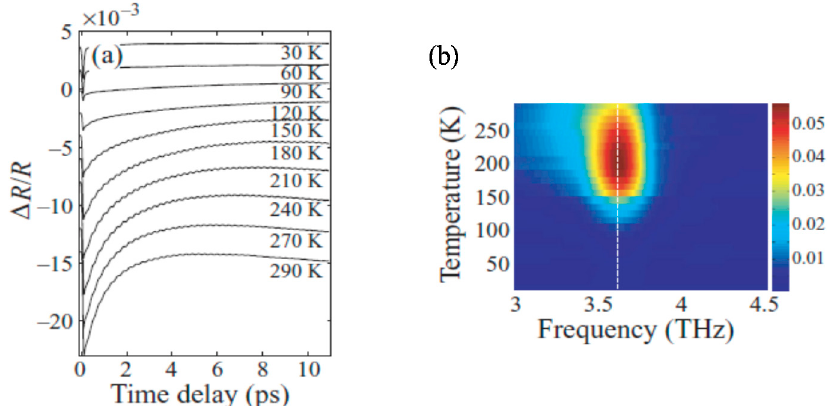
Figure 11. ( a ) Temperature dependence of the ∆ R/ R 0 signal in a LuMnO 3 film. ( b ) Image map of the temperature dependence of the FT amplitude spectrum of the oscillatory structure in ( a ) [24]. © IOP Publishing and Deutsche Physikalische Gesellschaft. Reproduced by permission of IOP Publishing. CC BY-NC-SA.